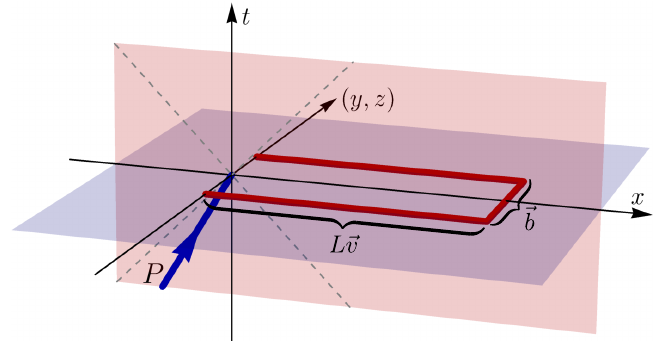
Figure 1 . The geometrical configuration of the matrix element (2.1). The red lines represent the operator, and the blue line represents the hadron